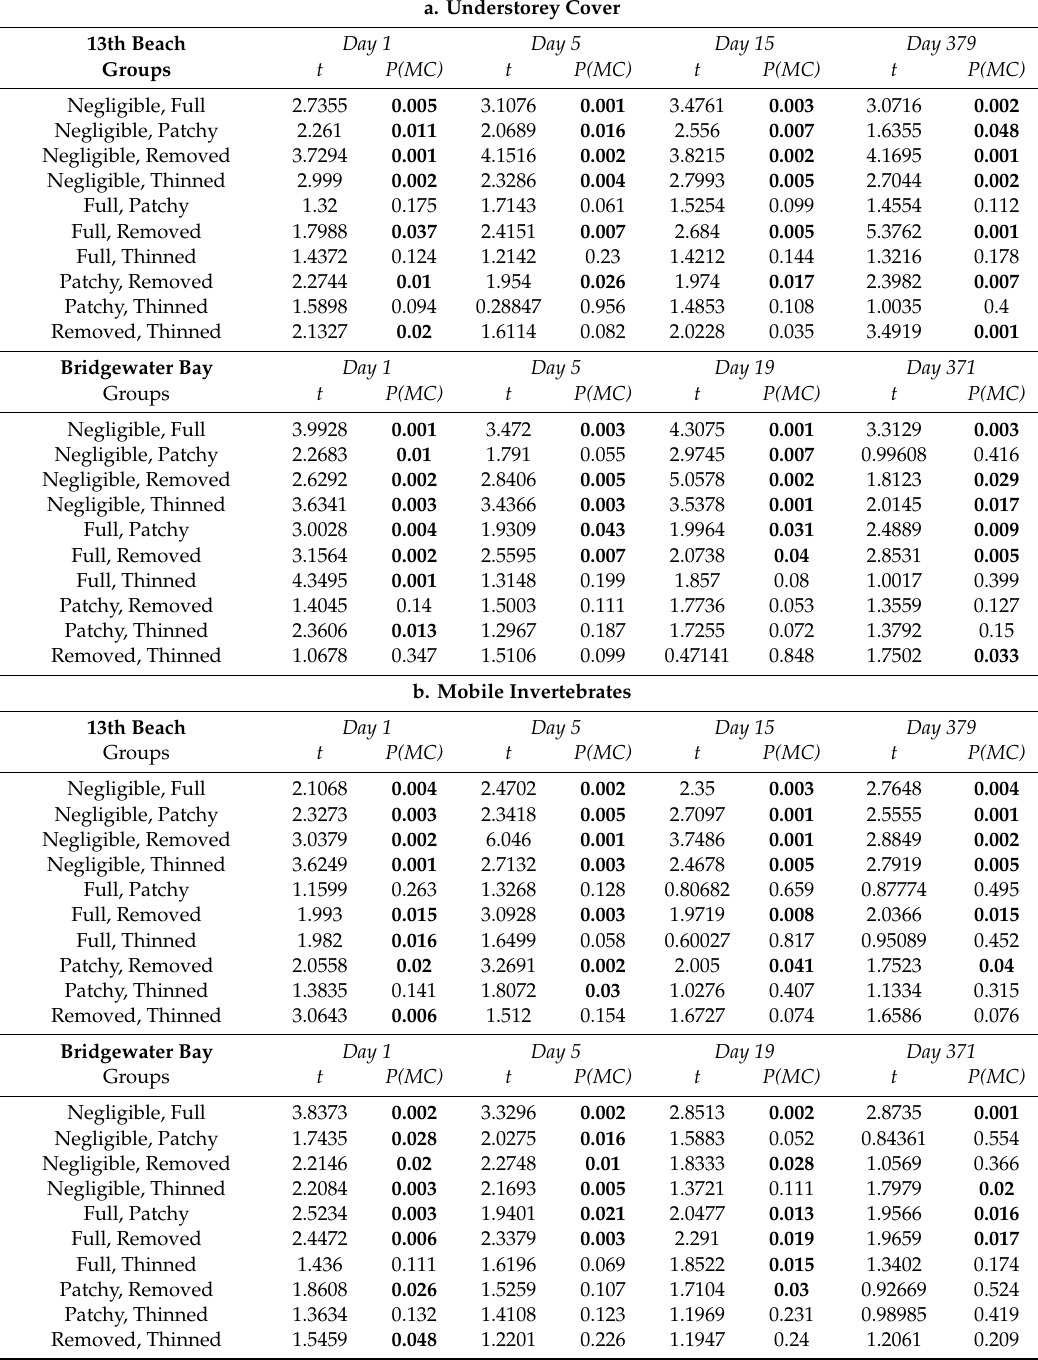
Table 2. Pairwise comparisons of ( a ) understorey cover and ( b ) mobile invertebrate assemblages between Hormosira-canopy treatment groups by sites following Permutational multivariate analysis of variance (PERMANOVA) on the significant treatment × site interaction terms. P(MC) is the P -value based on Monte Carlo random draws provides a more robust significance value with the reduced number of possible permutations in pairwise tests; statistical significance ( α = 0.05) is indicated in